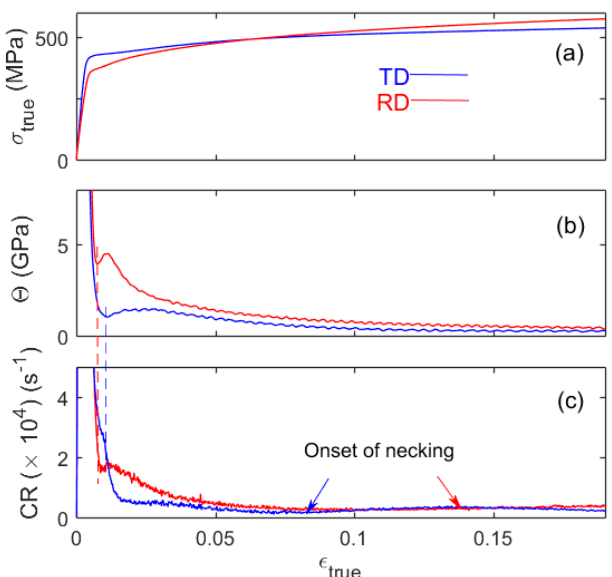
Figure 3. ( a ) True deformation curves for the samples of Figure 2; ( b ) strain dependence of the work-hardening rate Θ ; and ( c ) strain dependence of the AE average count rate CR. Vertical dashed lines indicate the A/B transition.